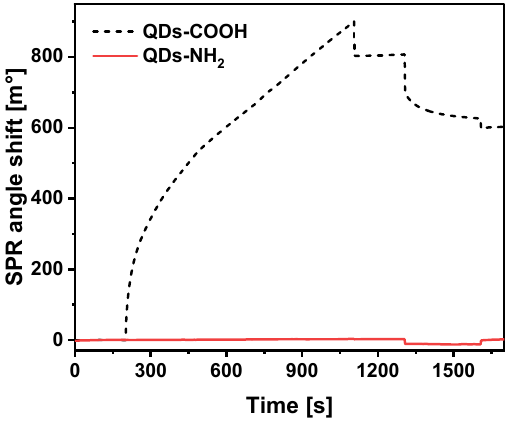
Figure 3. Non-specific adsorption of QDs-NH 2 and QDs-COOH on the surface of Au/CD44. The regeneration procedure is important for multiple uses of SPR sensors. In the pro-